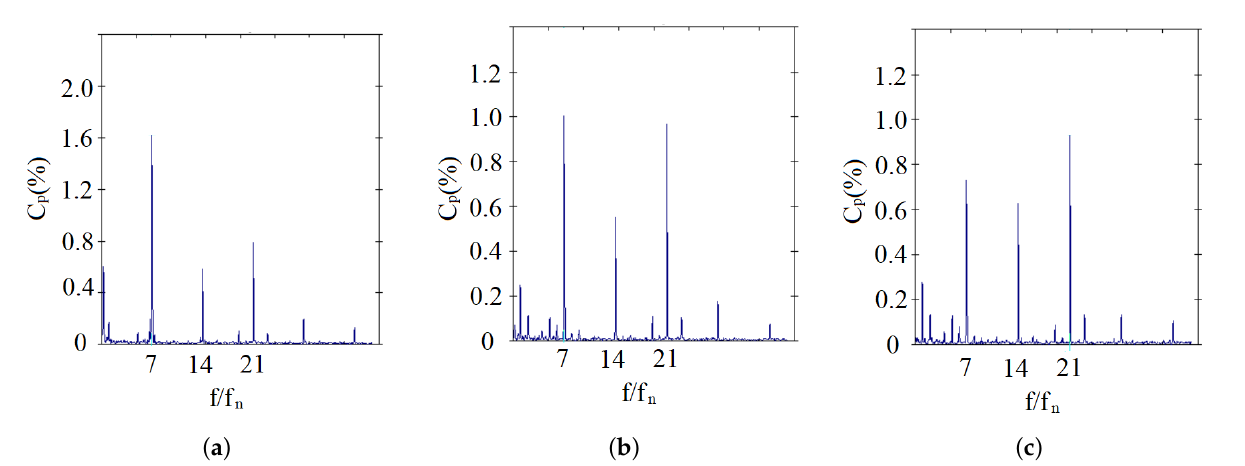
Figure 3. Field measurement results of pressure fluctuations in the vaneless space at three load condi- tions. ( a ) 60% load. ( b ) 86.7% load. ( c ) 100%